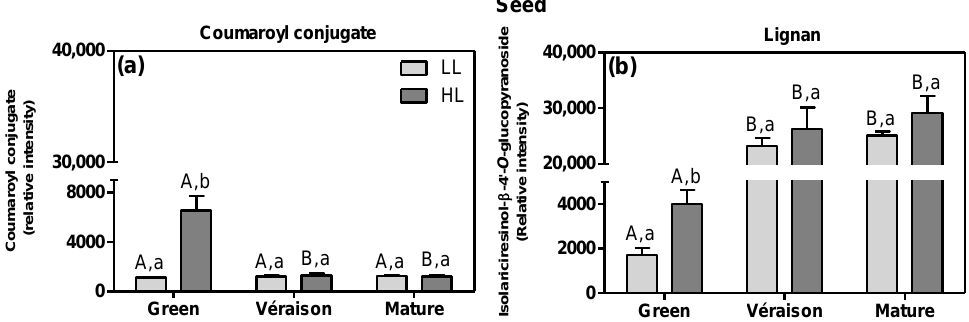
Figure 5. Examples of seed hydroxycinnamic acids, ( a ) a coumaroyl conjugate (ID 285) and ( b ) a lignan type—isolariciresinol-β-4′- O -glucopyranoside (ID 613) detected by LCMS (mean values + SD, n = 8–12) significantly differing between canopy microclimates (LL and HL; independent of mitigation treatment) and at three developmental stages (green, véraison and mature). Statistical analysis (two-way ANOVA, p ≤ 0.05) was applied after data Log 2 transformation. Statistical notation is the same as in Figure 3.